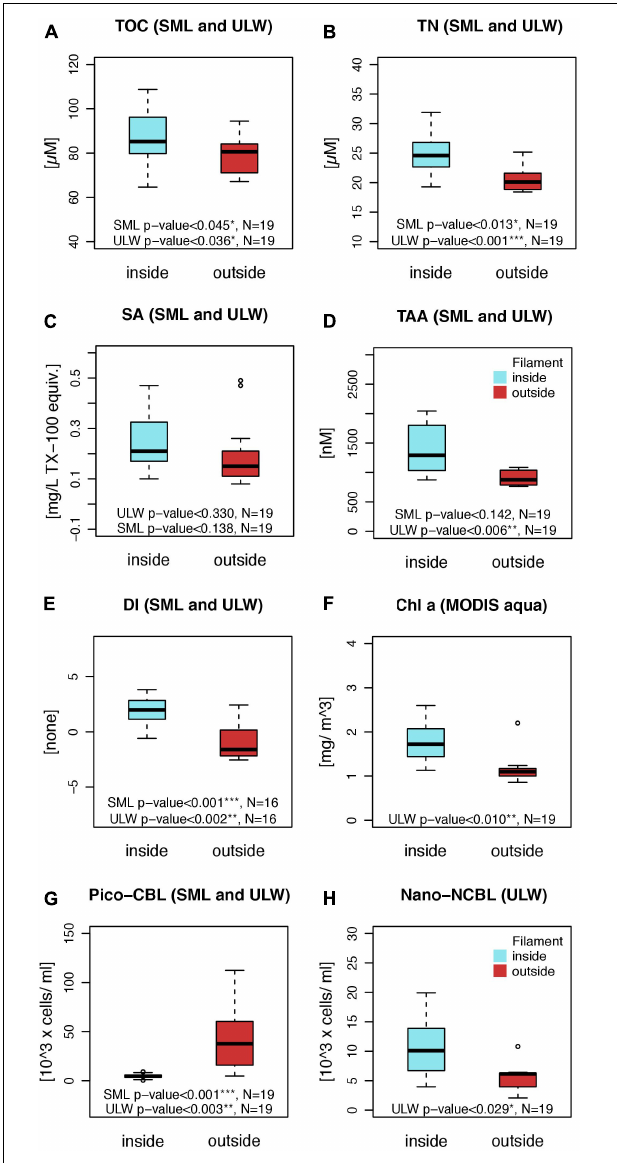
FIGURE 3 | Organic matter concentration difference across the filament’s front in the SML and ULW. Average concentration of (A) total organic carbon (TOC) and (B) total nitrogen (TN), (C) surface activity (SA), (D) total amino acids (TAA), and (E) degradation indices (DI), which were derived from the relative contribution of molecular amino acid concentrations. Differences across the filaments front of (F) bulk Chlorophyll a derived from the satellite MODIS aqua by NASA and of certain phytoplankton groups: (G) Averaged abundance of pico-CBL cells ( Synechococcus spp.) in the SML and ULW and (H) nano-NCBL (eukaryotic, Non-Cyanobacteria-Like cells) in the ULW. Differences were tested independently for the SML and ULW and significances of the Mann–Whitney U -test are indicated below the boxplots. Supplementary Information is provided in Supplementary Table S2